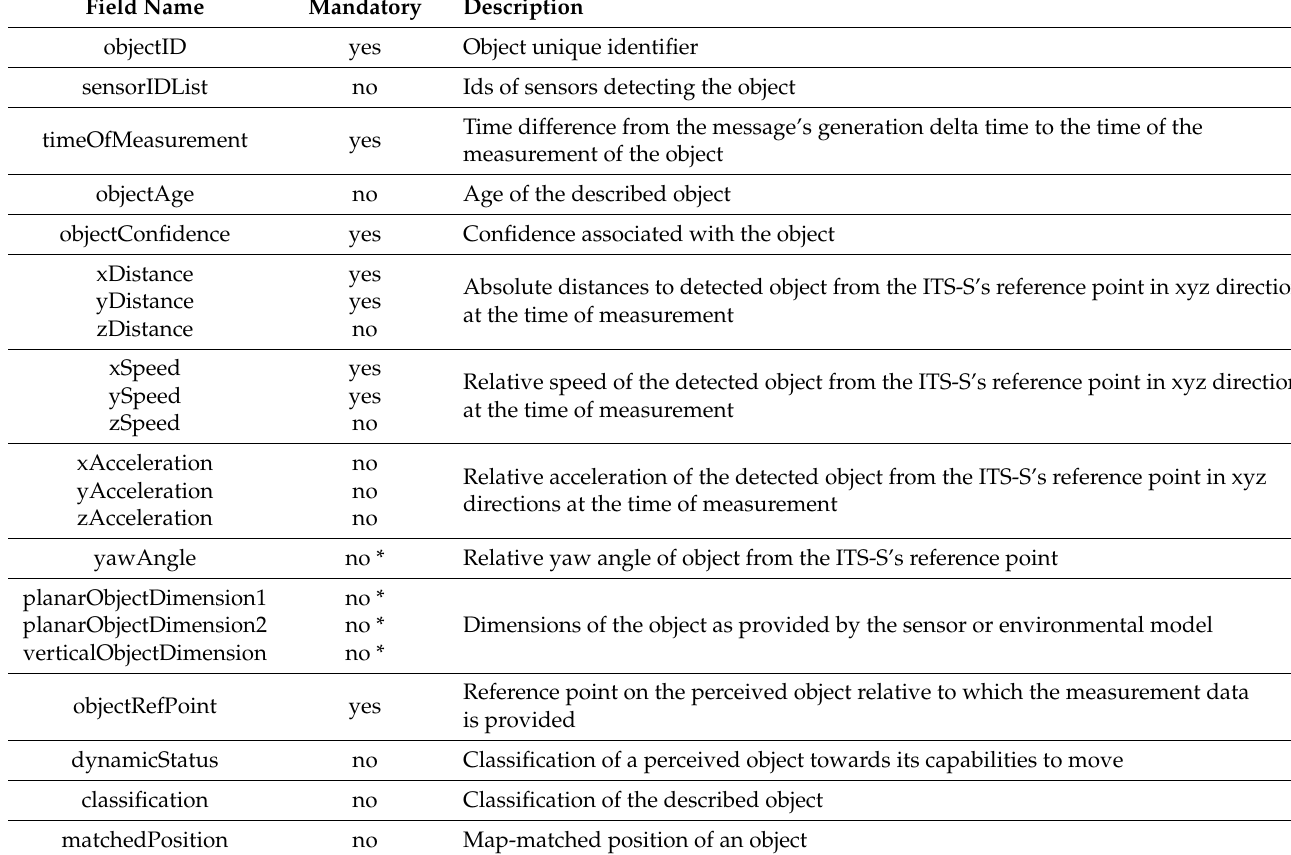
Table 1. Perceived Object Container in CPM. Optional fields marked with * were used on this